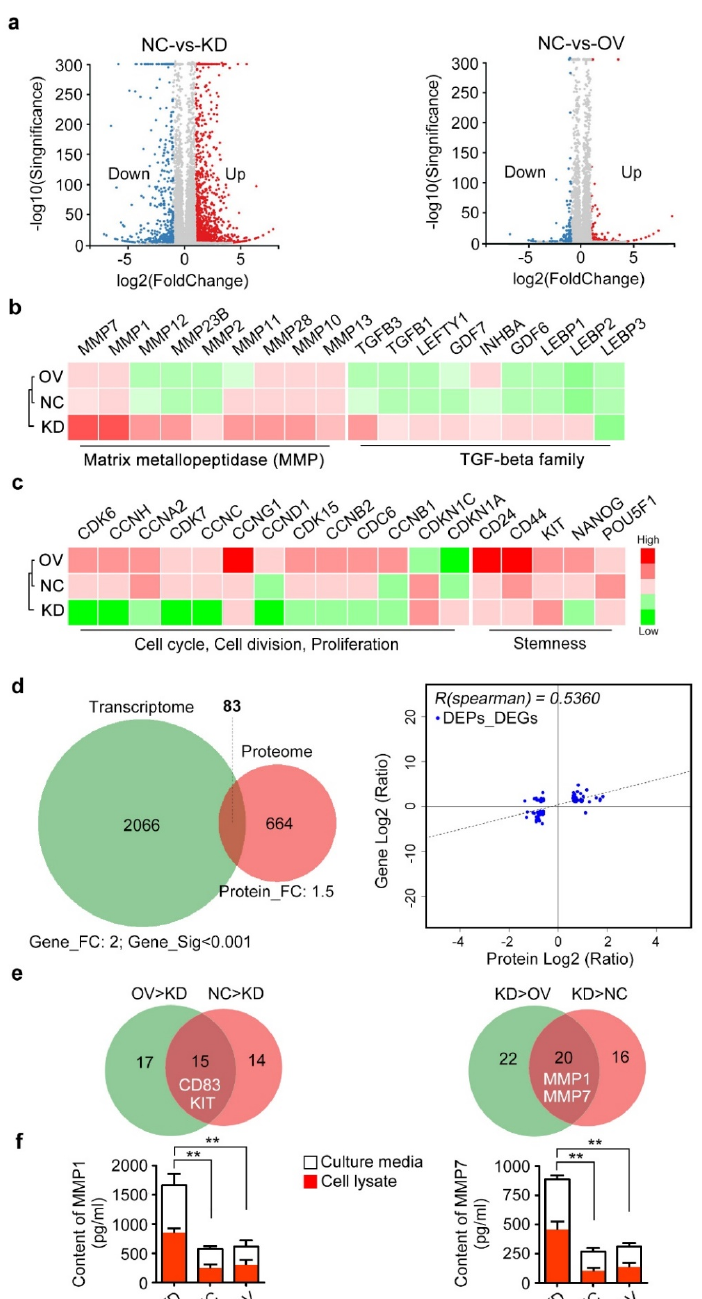
Figure 4. Integrated transcriptome and proteome analyses. ( a ) Volcano plots show the di ff erentially expressed genes of NC-vs.-KD and NC-vs.-OV, as revealed by transcriptome. ( b ) CD83-KD SKOV3 cells exhibited elevated expression of matrix metallopeptidases (MMPs) and TGF-beta family members as compared with NC and CD83-OV cells. ( c ) The expression of cell cycle regulators and stemness-related genes was upregulated in CD83-OV SKOV3 cells. ( d ) The intersection of the transcriptome (fold change ≥ 2) and proteome (fold change ≥ 1.5) identified 83 DE proteins (and protein-coding genes) between CD83-KD and NC SKOV3 cells. Correlation analysis of DE genes and DE proteins indicated the consistency (R = 0.5360) between transcriptome and proteome in this study. ( e ) Venn diagram shows the downregulated proteins (e.g., CD83, KIT) and upregulated proteins (e.g., MMP1, MMP7) in the CD83-KD SKOV3 cells. ( f ) Content of MMP1 and MMP7 in SKOV3 cell lysate and culture media by ELISA assay. The di ff erences between KD and NC, as well as KD and OV, were presented as the mean ± SEM; Student’s t -test; ** p <